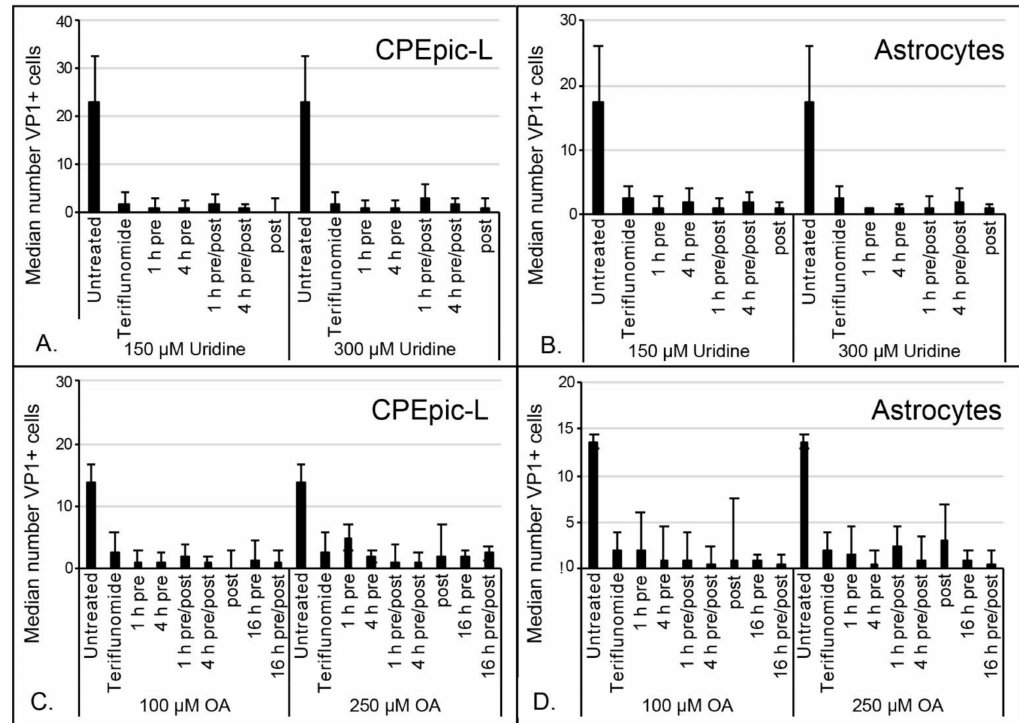
Figure 4. Uridine or orotic acid failed to rescue JCPyV infection in teriflunomide-treated cells. CPEpic-L ( A , C ) and primary astrocytes ( B , D ) were infected and untreated or treated with teriflunomide, and treated with uridine ( A , B ) or orotic acid ( C , D ). Cells were treated with uridine for 1 h or 4 h prior to teriflunomide and maintained in teriflunomide only; or treated with uridine for 1 h or 4 h and maintained in both teriflunomide and uridine; or maintained in both uridine and teriflunomide without uridine pretreatment. Cells were treated with orotic acid for 1 h, 4 h, or 16 h prior to teriflunomide and maintained in teriflunomide only; or treated with orotic acid for 1 h, 4 h, or 16 h and maintained in both teriflunomide and orotic acid; or maintained in both orotic acid and teriflunomide without orotic acid pretreatment. All conditions were carried out in triplicate at high and low concentrations of uridine (300 µ M and 150 µ M, respectively) or orotic acid (250 µ M and 100 µ M, respectively) and using the previously established highest tolerable doses of teriflunomide as appropriate per cell type. Neither uridine nor orotic acid was able to rescue JCPyV infection under any of the tested conditions; there are no significant differences between the teriflunomide only treated samples and the orotic acid or uridine treated samples ( p > 0.05 for all conditions containing uridine and orotic acid; Student’s t -test). Error bars indicate the interquartile range of each treatment. OA = orotic acid; VP1 = viral protein